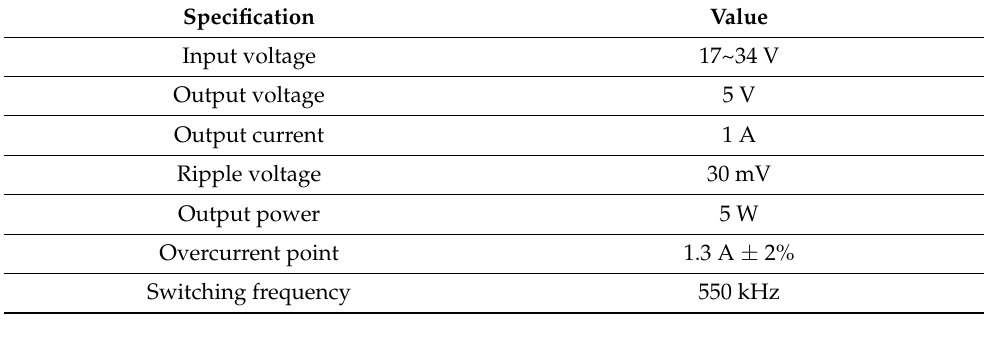
Table 1. Specifications of the realized prototype.